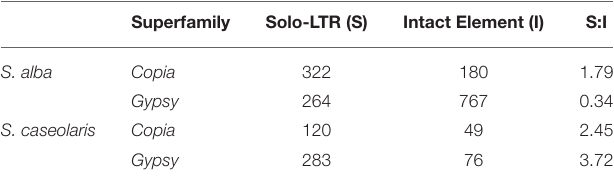
TABLE 2 | Comparison of the ratios of solo-LTRs to intact elements (S:I) for Copia and Gypsy superfamilies.